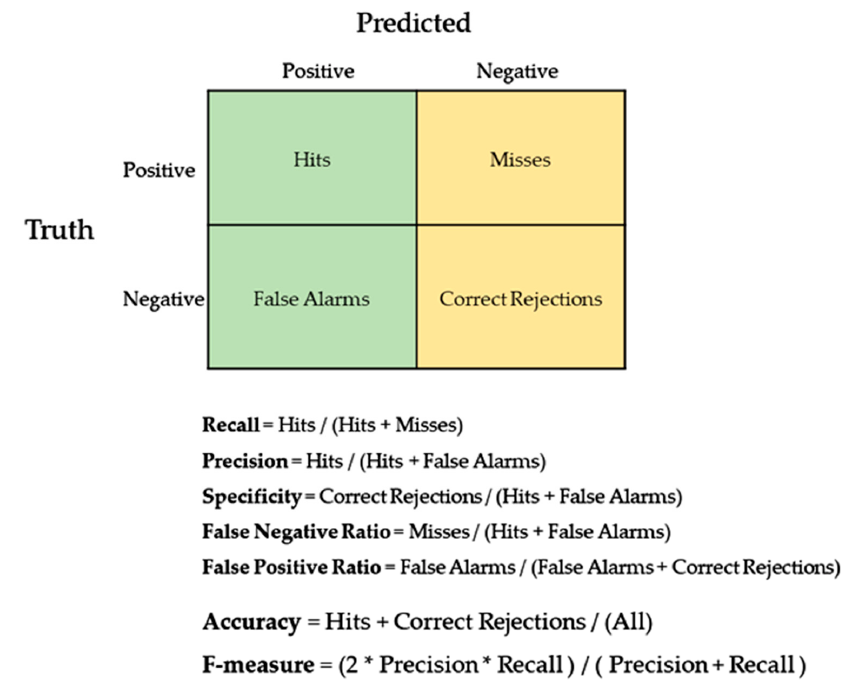
Figure 1. Computations for the prediction performance